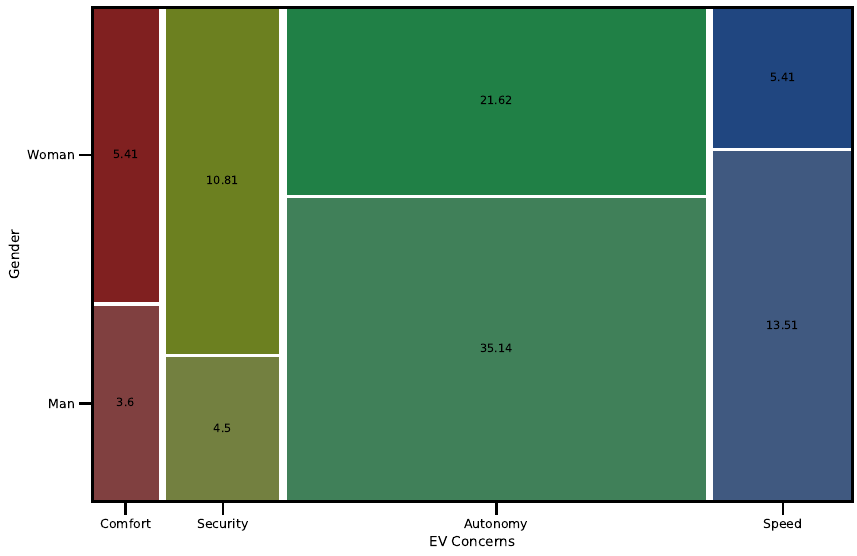
Figure 9. Mosaic plot of the EV concerns based on